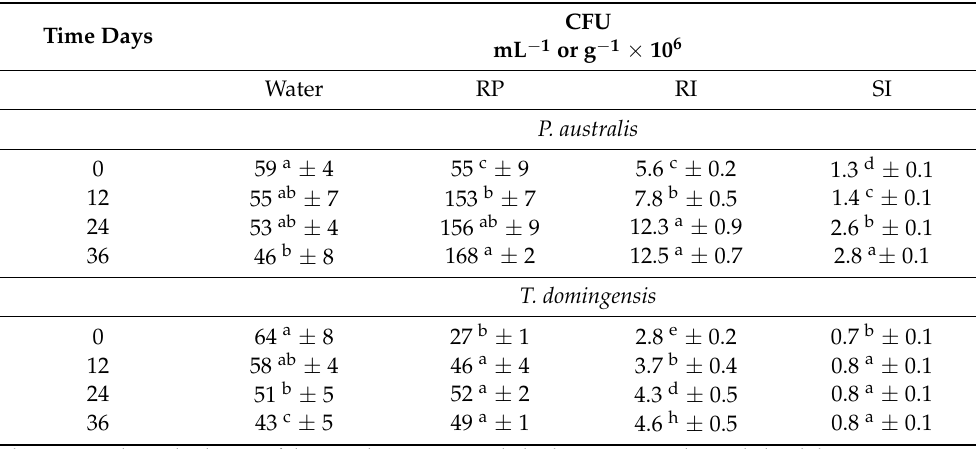
Table 2. Total colony forming units (CFU) in the water, rhizoplane (RP), root interior (RI), and shoot interior (SI) of Phragmites australis and Typha domingensis in bioaugmented FTWs. Time Days